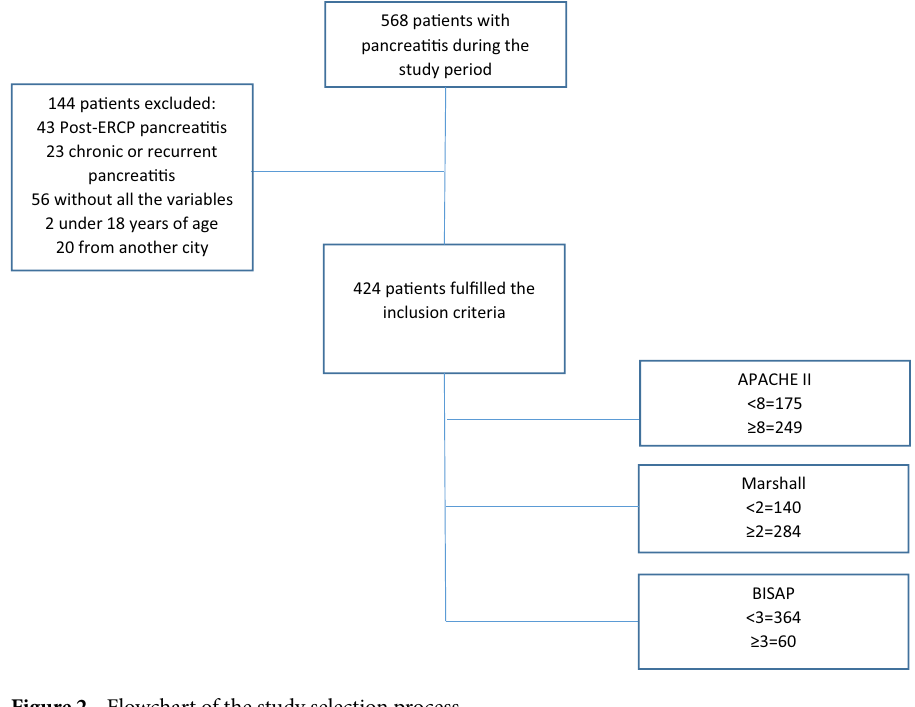
Figure 2. Flowchart of the study selection